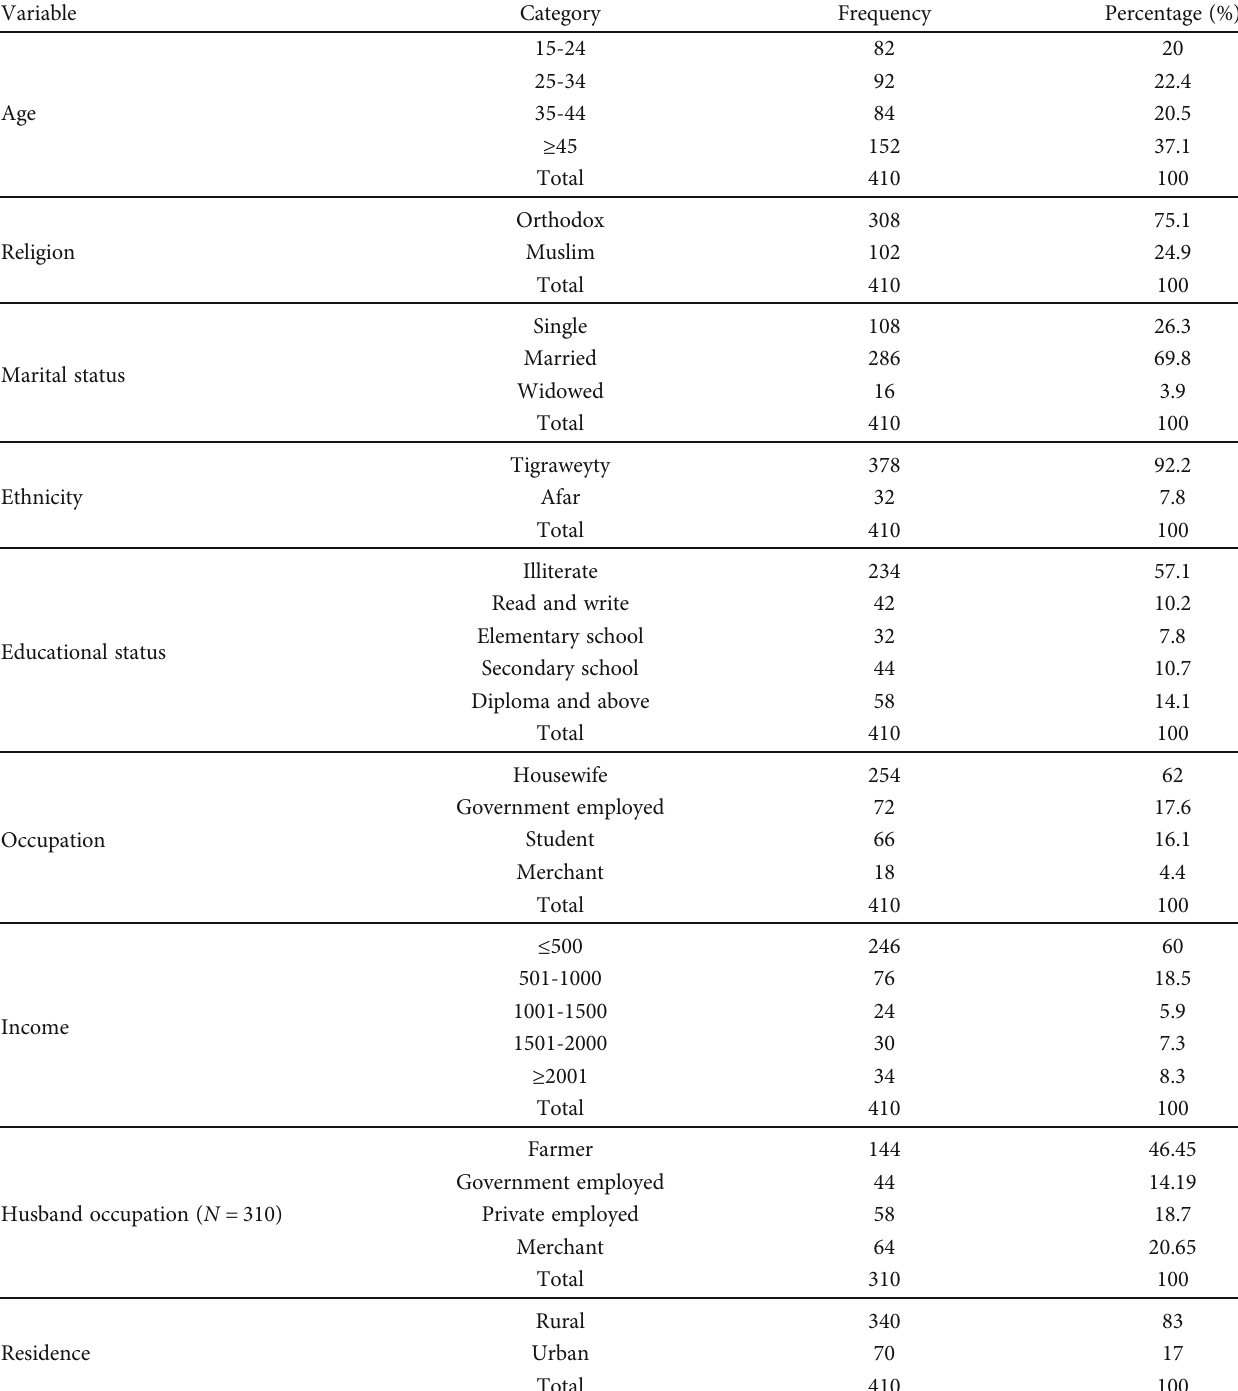
Table 1: Sociodemographic characteristics of respondents among reproductive-age women in southeastern zone of Tigray, Ethiopia, 2021 ( N = 410